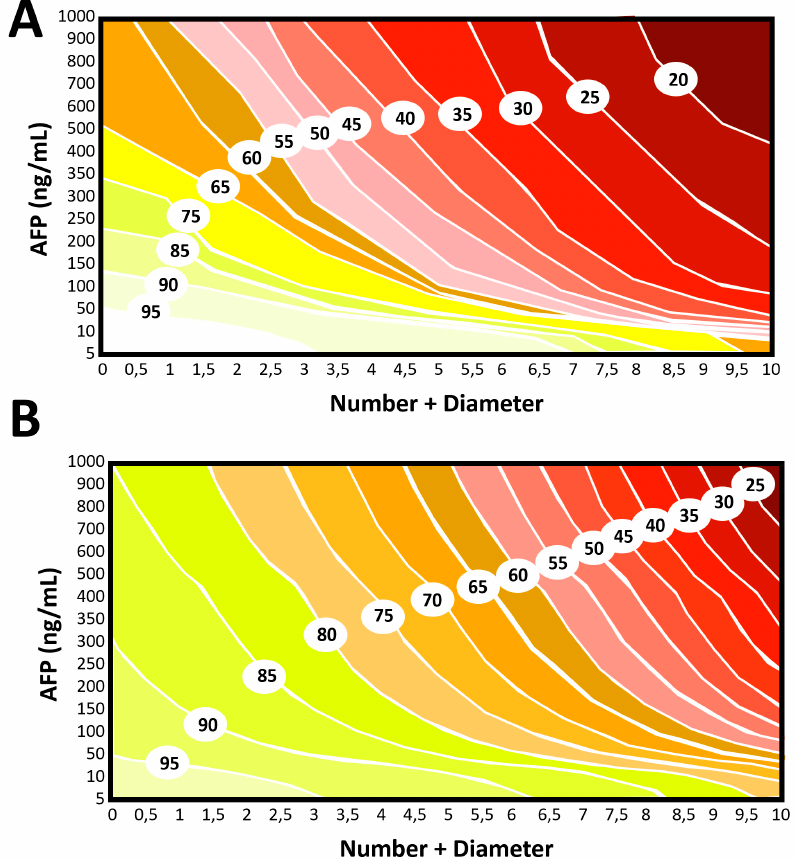
Figure 2. ( A ) Contour plot showing the five-year risk of post-transplant HCC-related survival estimated using the present “first referral” model. ( B ) Contour plot showing the five-year risk of post-transplant HCC-related survival estimated using the Metroticket 2.0 Score (variables evaluated at the time of LT).